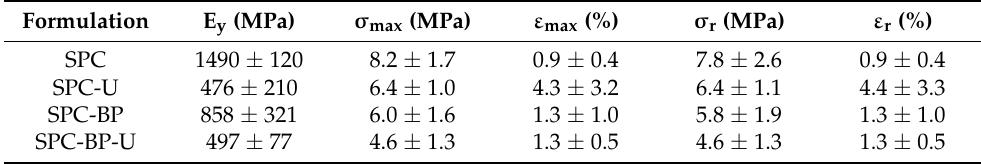
Table 4. Tensile properties 1 of the injection-molded pieces.